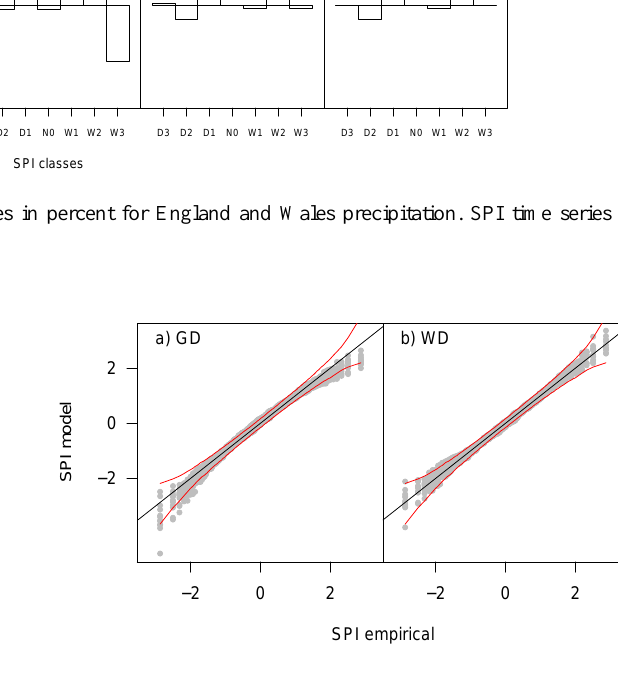
Fig. 5. SPI quantile-quantile plots based on (a) GD and (b) WD transformations and empirical SPI values. 95% confidence interval for standard normally distributed data is given by red lines.